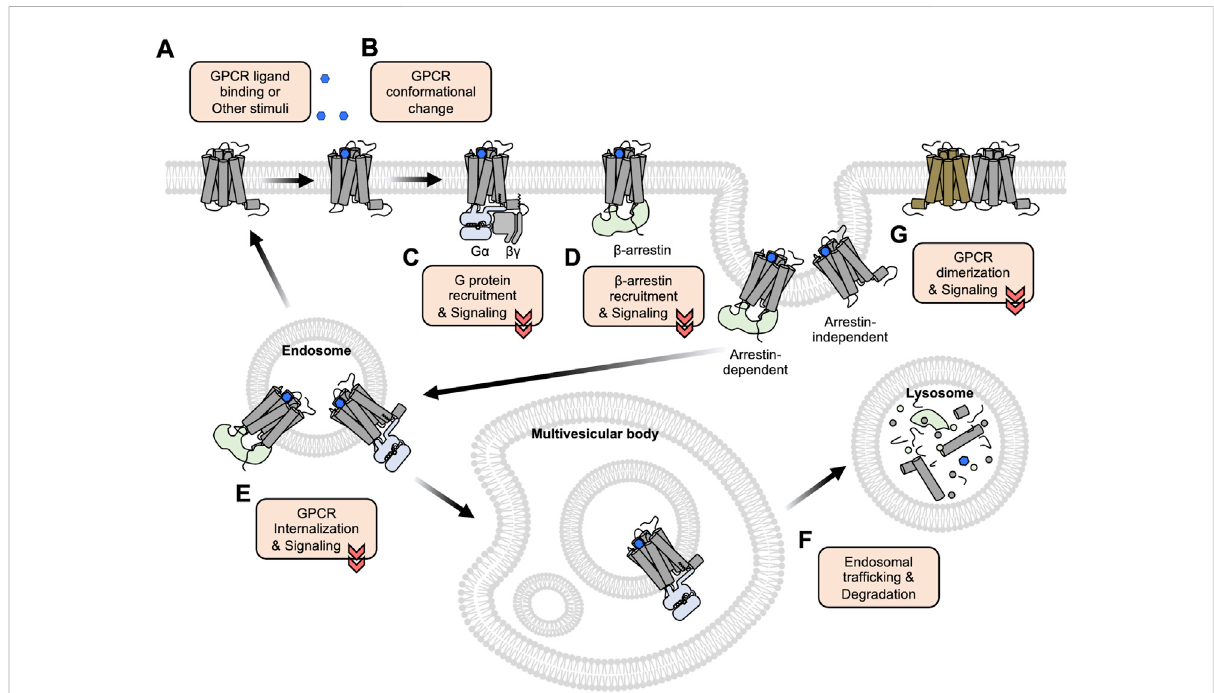
FIGURE 1 An overview of GPCR activation, traf fi cking, and degradation. (A) GPCRs bind to the extracellular ligands or other stimuli at the plasma membrane. (B) The ligand-bound GPCRs change their conformations, in particular between TM5 and TM6. (C – D) The conformational changes of the GPCRs induce the recruitment of G proteins (C) or β -arrestin (D) to initiate the downstream signaling pathways. (E) The recruited β -arrestin promotes the internalization of GPCRs via the clathrin-mediated endocytosis pathway. Some GPCRs can maintain their activity and function at the internalized endosomes or subcellular organelles. (F) Following the endosomal traf fi cking pathways, the GPCRs can fi nally be degraded in the lysosome. (G) Some GPCRs form dimers or oligomers. Functional crosstalk between these GPCRs may in fl uence the ligand binding af fi nity, downstream signaling pathways, and traf fi cking